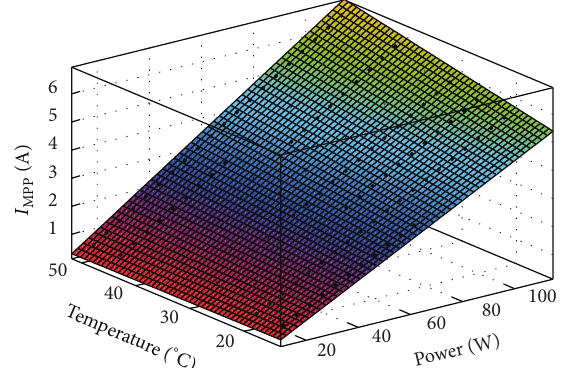
Figure 13: P - T - I characteristic surface of the MPPs.